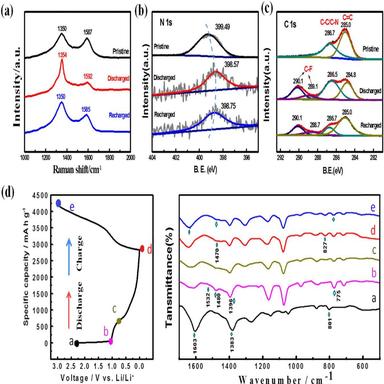
(a) Raman spectra of cPAN nanofibers recorded at different state. (b) N 1s of cPAN nanofibers performed at different state. (c) C 1s of cPAN nanofibers performed at different state. (d) FT-IR spectra of the cPAN nanofibers during the lithium intercalation process: (a. pristine state; b. discharged to 0.95 V; c. discharged to 0.75 V; d. fully discharged to 0.001 V; e. fully recharged to 3.0 V).